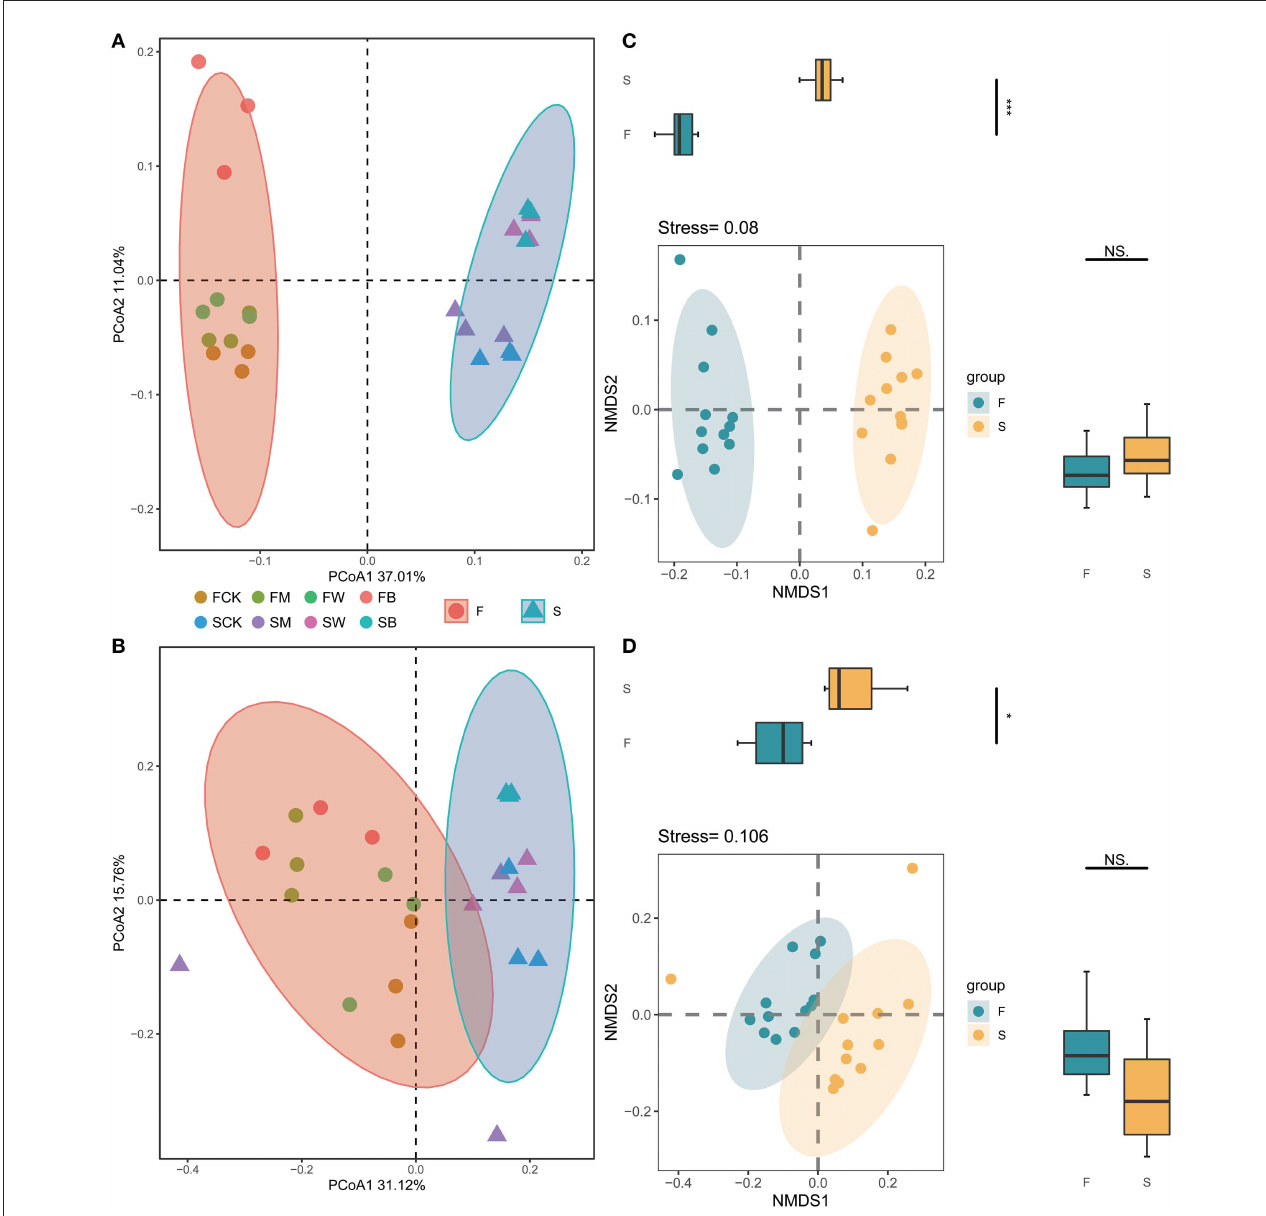
FIGURE3 Effect of crop straw return on soil microbial community β -diversity. Principal coordinate analysis (PCoA) of the bacterial 16S rRNA gene (A) and fungal ITS gene (B) communities subjected to different treatments and nonmetric multidimensional scaling (NMDS) of the bacterial 16S rRNA gene (C) and the fungal ITS gene (D) communities subjected to different treatments. Each colored and shaped dot represents the